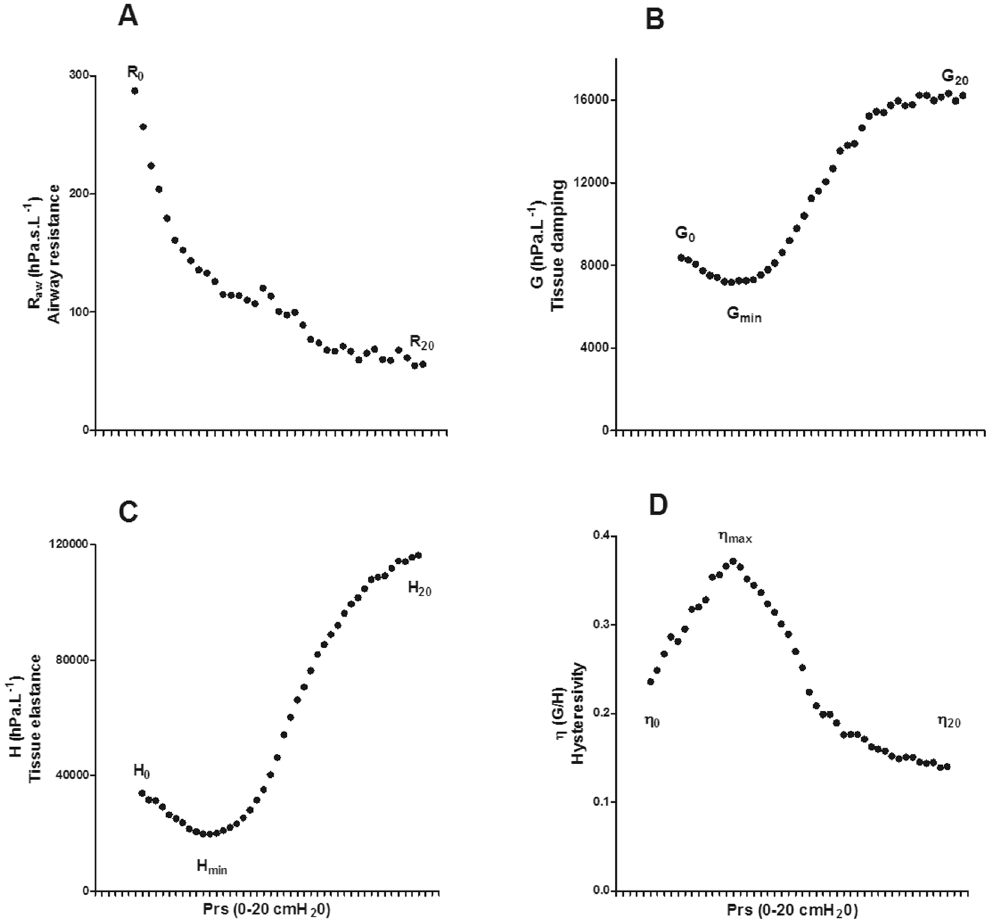
Figure 1. Mean R aw ( A ; Newtonian resistance ~ airway resistance), G ( B ; tissue damping), H ( C ; tissue elastance) and η ( D ; hysteresivity) plotted against transrespiratory pressure (Prs) for female vitamin D replete (Vit D + / + ) mice showing the characteristic pressure dependence of these parameters. In order to simplify the subsequent comparisons between groups we represented these curves by the indices indicated in the graphs; R 0 , R 20 , G 0 , G min , G 20 , H 0 , H min , H 20 , η 0 , η max , η 20